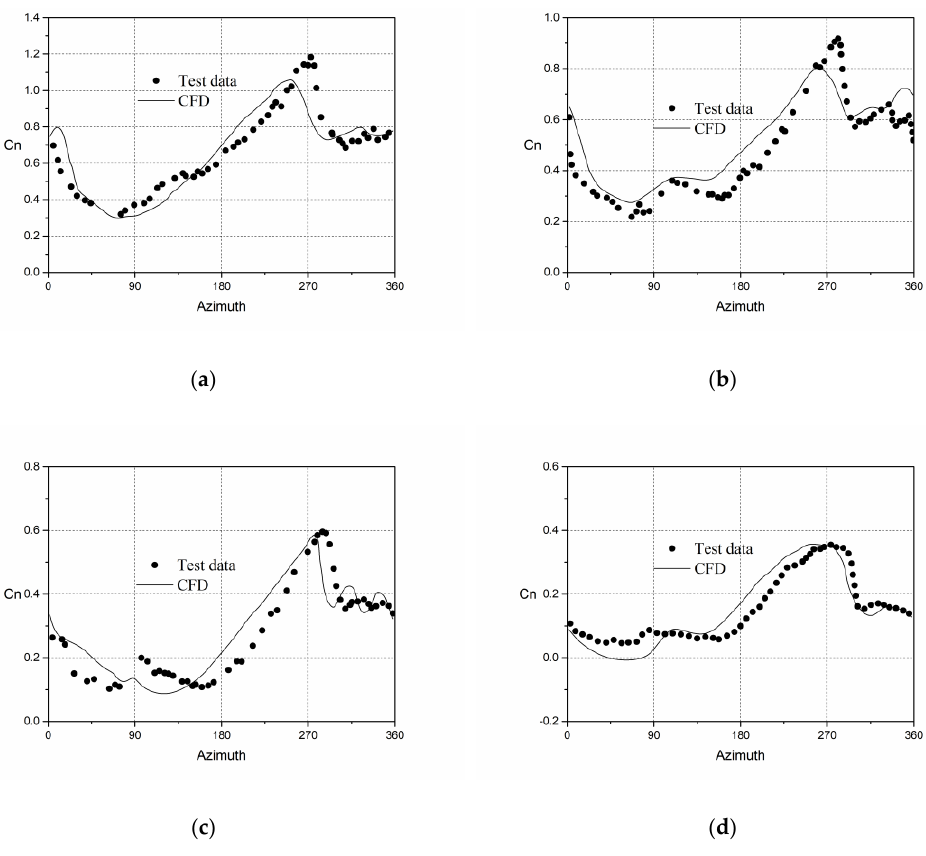
Figure 9. Normal force coefficients of AH-1 rotor vary with azimuth angles. ( a ) r/R = 0.60. ( b ) r/R = 0.75. ( c ) r/R = 0.91. ( d ) r/R = 0.99.